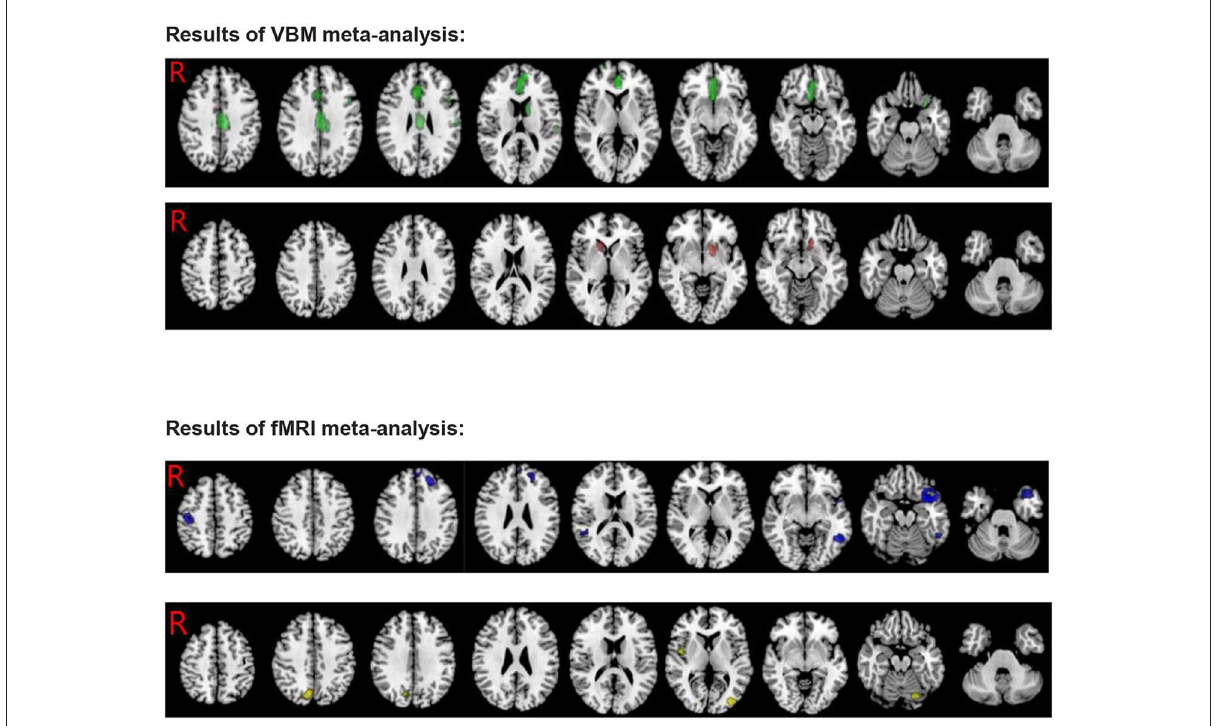
FIGURE2 Results of VBM and fMRI meta-analysis for ADHD (Green, GMV decreased in ADHD; Red, GMV increased in ADHD; Blue, hypoactivation in ADHD; Yellow, overactivation in ADHD).